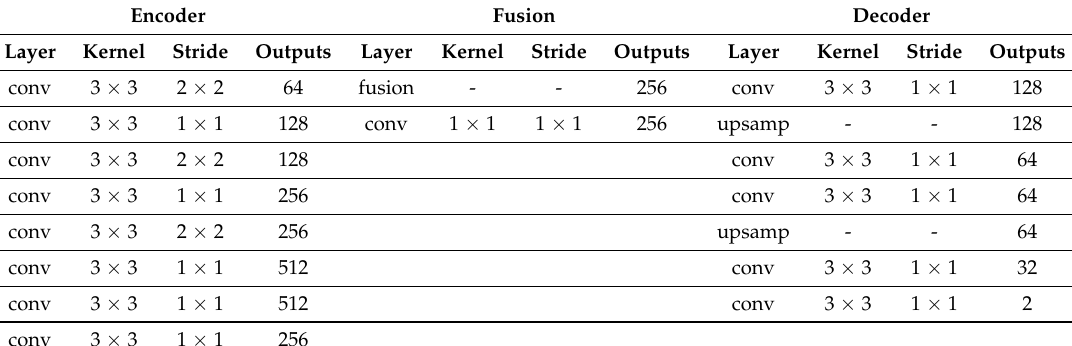
Table 2. Details of network architecture; Left: encoder network, mid: fusion network, right: decoder network.